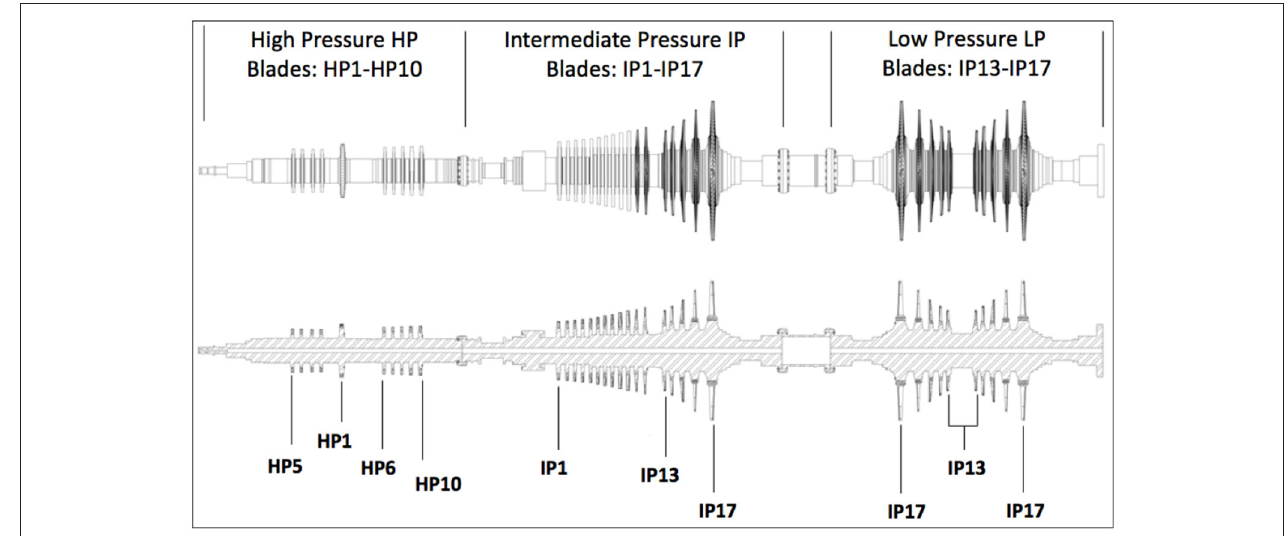
FIGURE 1 | High, intermediate and low pressure turbines with numbered